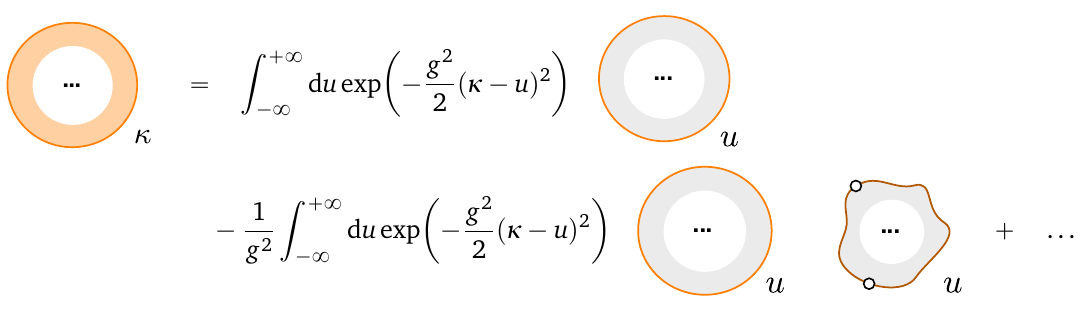
p κ q (left) in our two- 0